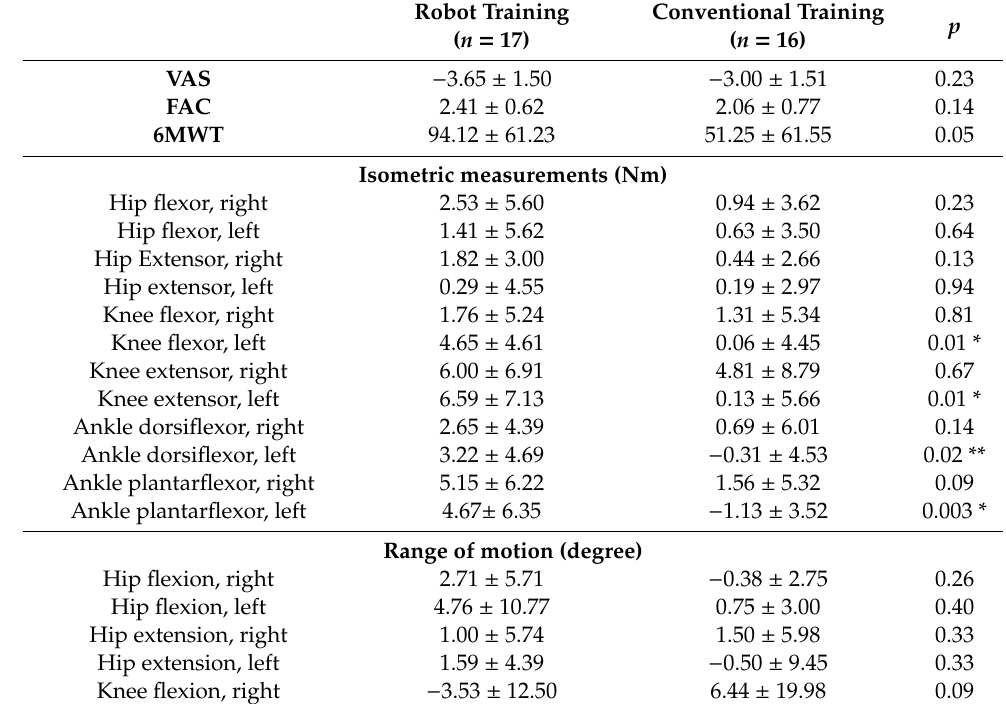
Table 3. Change scores (before and after training) on measured